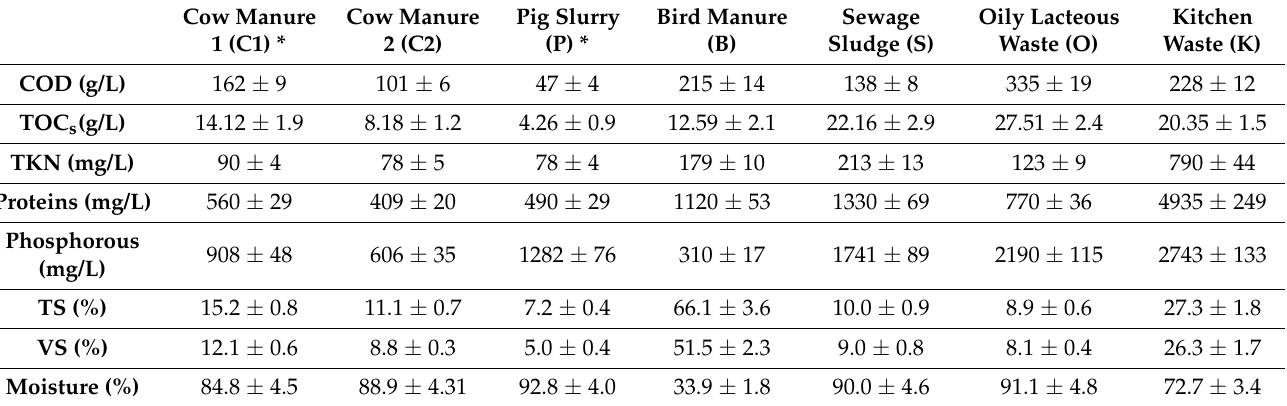
Table 2. Characterisation of the organic waste used in the